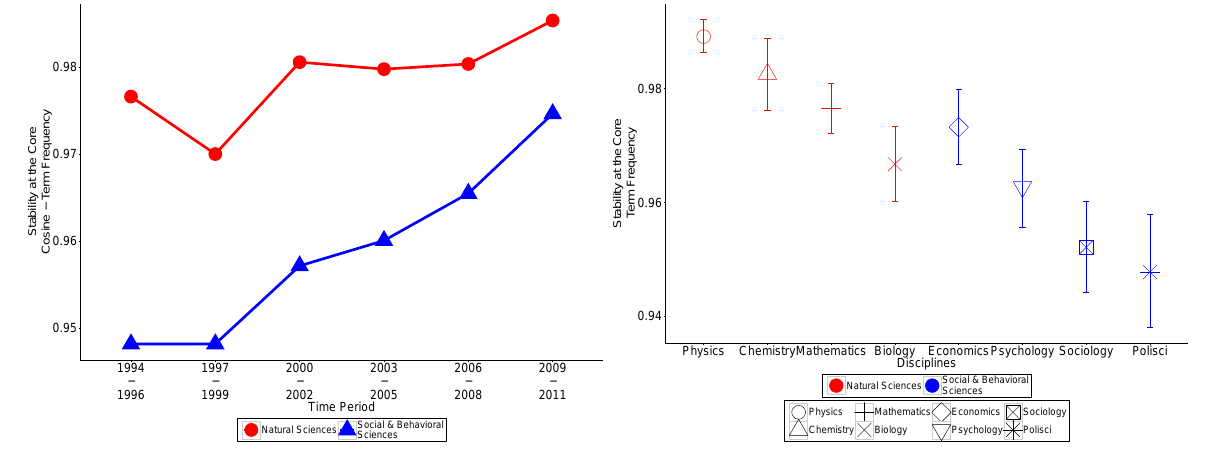
Figure 5: Stability values over time by science/social science group and discipline. x-axis. The lines and shading in in Figure 6 show the correlations (with 95 percent confidence intervals) between the pairs of measures. The eight dots represent